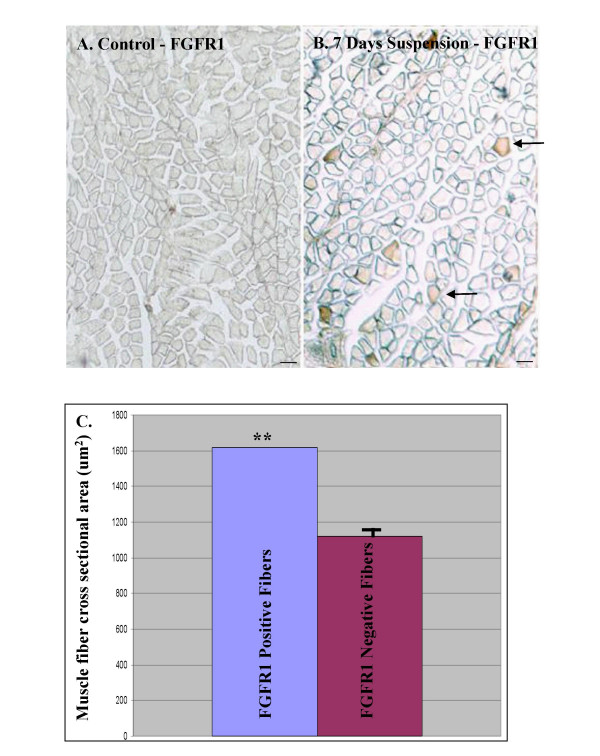
FGFR1 protein is up-regulated in muscle fibers during disuse atrophy. FGFR1 was immunolocalized in sections of gastrocnemius muscle obtained from control mice or mice suspended for 7 days. In comparison to the control gastrocnemius (A), FGFR1 protein, as depicted by the brown precipitate (black arrows), was increased in atrophying muscle (B). In sections of the gastrocnemius isolated from suspended mice, the area of the FGFR1-positive muscle fibers was significantly greater than the FGFR1 negative fibers (C). The area of the FGFR1 positive myofibers in the atrophying muscle was the same as the area of control myofibers (1688 mm2). This data suggests that FGFR1 acts to inhibit fiber atrophy associated with disuse. ** indicates p < .01; SEM indicated; bar represents 50 mm.